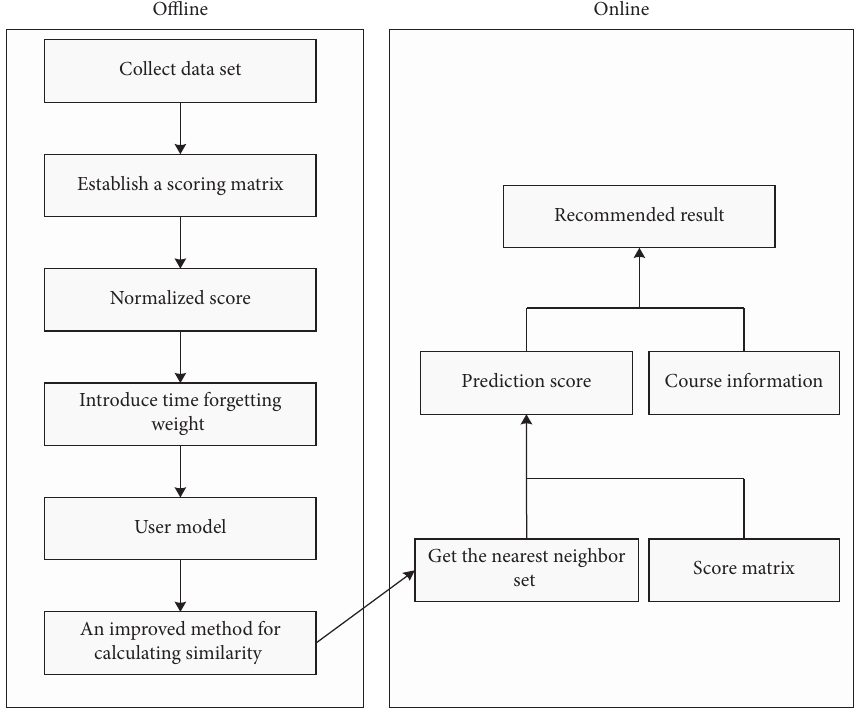
Figure 1: The workflow of collaborative filtering recommendation algorithm with improved user